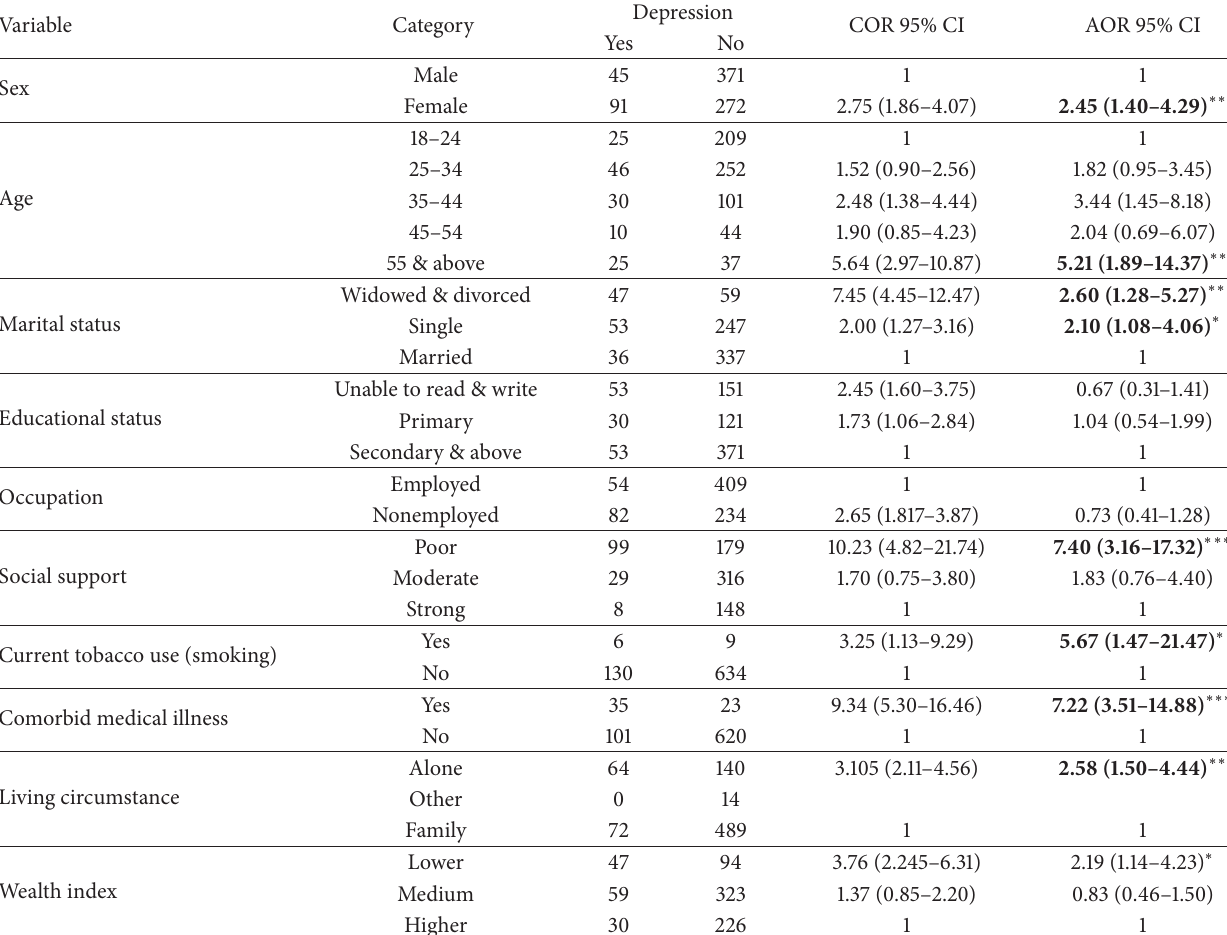
Table 2: Bivariate and multivariate analysis of depression among adults of Ebinat town, Northwest Ethiopia,